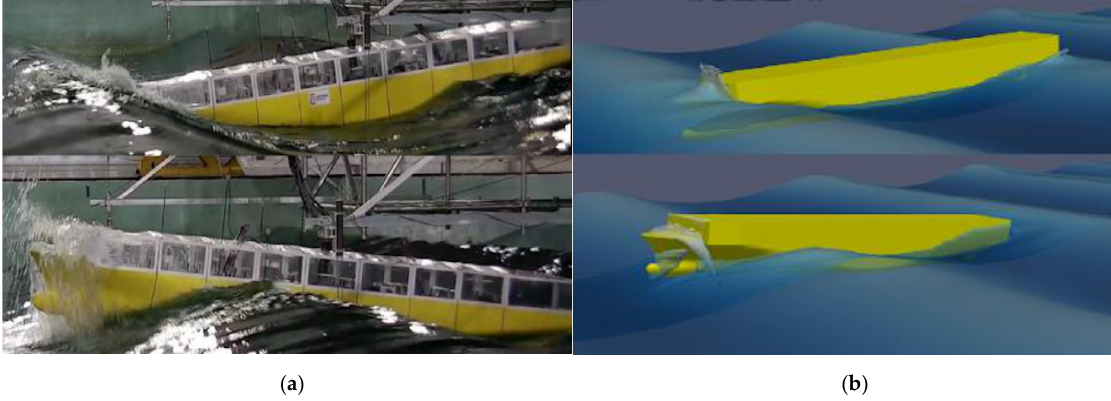
Figure 19. 6750 TEU containership in wave case 5. ( a ) Experiment photography; ( b ) OpenFOAM snapshot.